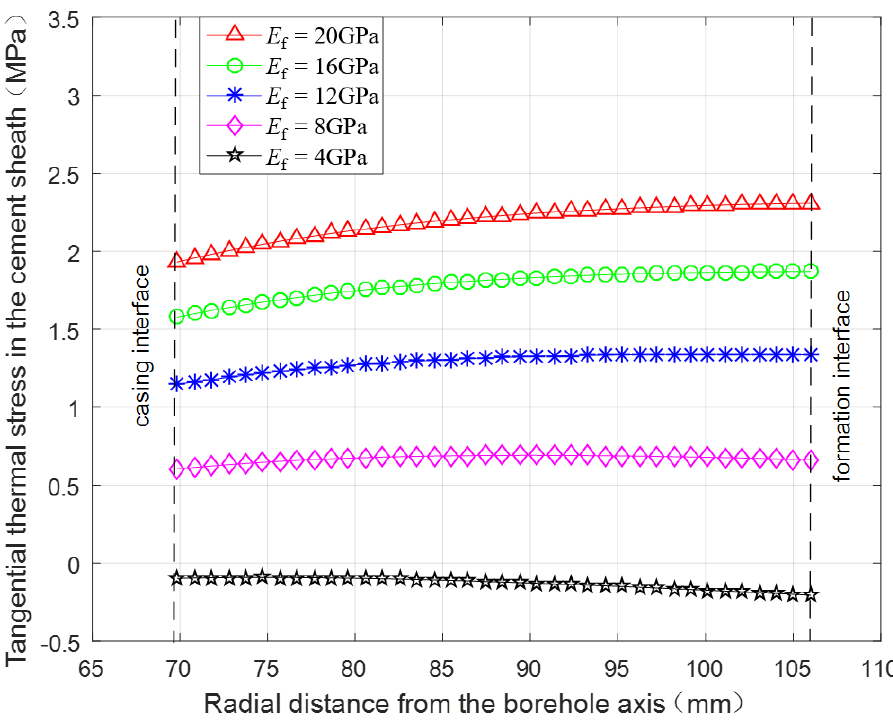
Figure 17. Radial distribution of the tangential thermal stress in the cement sheath under different elasticity moduli of the formation.